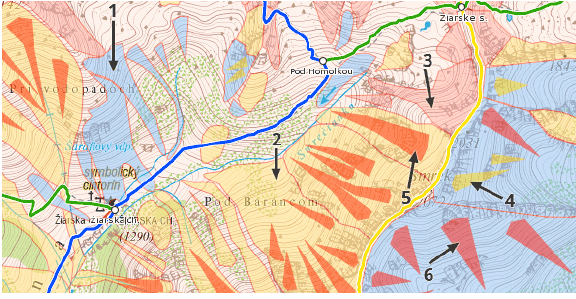
Figure 3: Slovakian avalanche map, example from the Žiarska valley. Blue colour = slopes with an infrequent occurrence of avalanches; yellow = slopes with frequent occurrence of avalanches; red = slopes with very frequent occurrence of avalanches. Triangular shapes in orange, red and yellow within a given avalanche frequency zone mark avalanche paths with a higher frequency than the respective zone they are located in would indicate. (Map source: Copyright © HZS, hiking.sk,